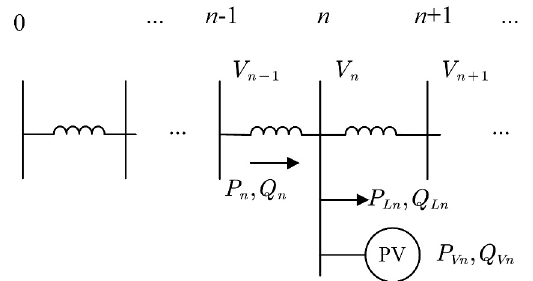
Fig. 2. Simplified feeder of distribution